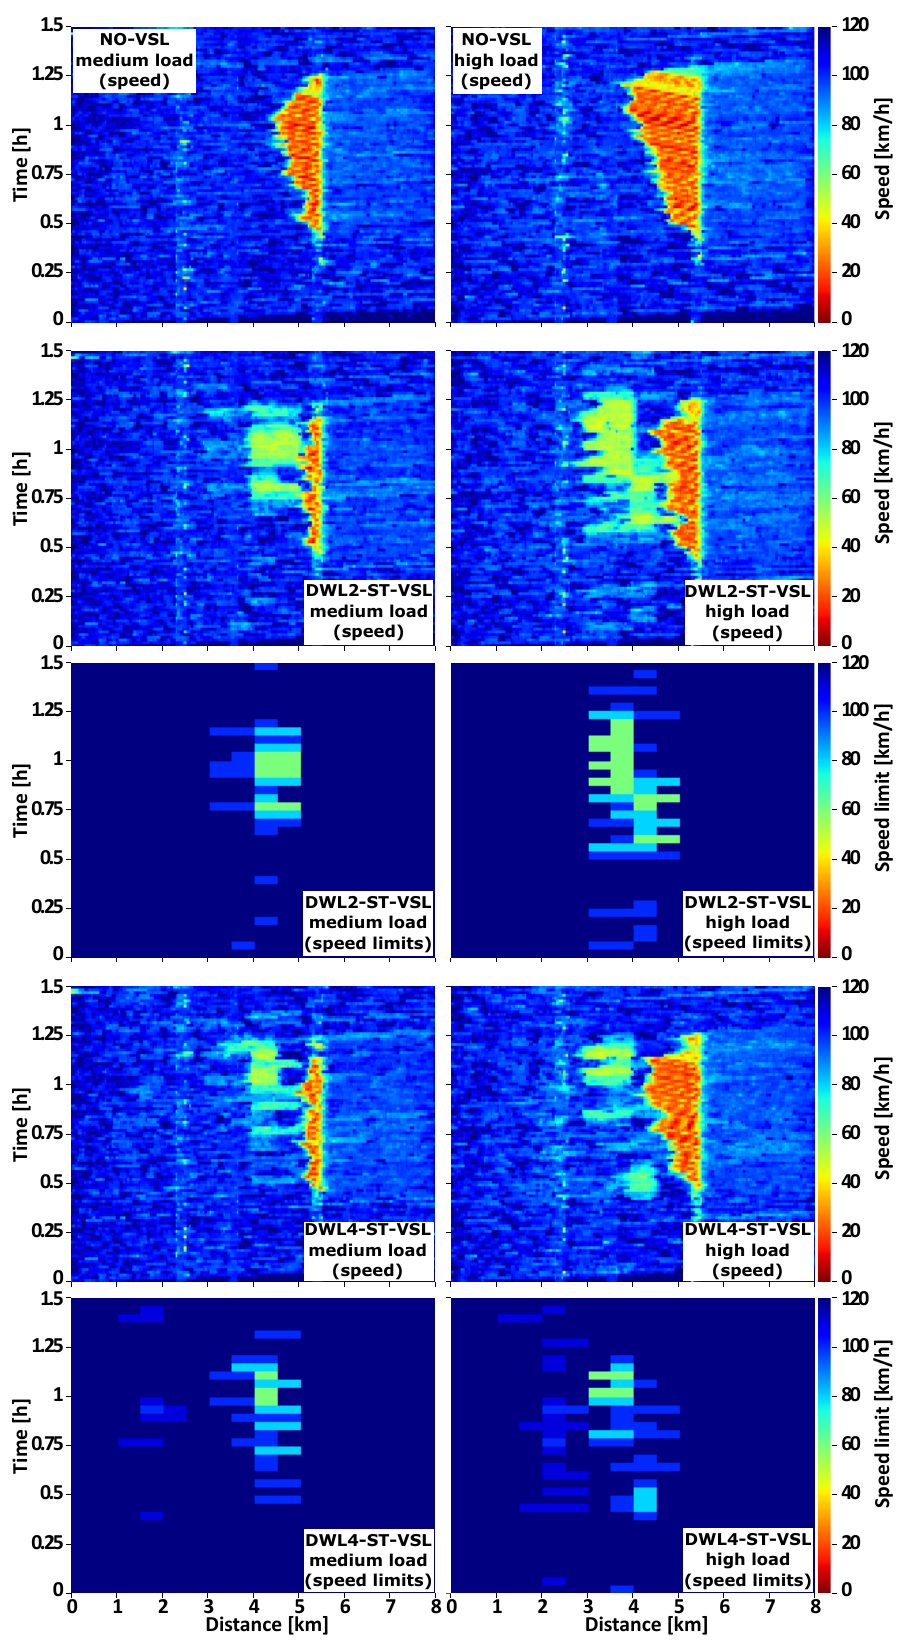
Figure 5. Space-time diagrams for simulated scenarios with multi-agent dynamic VSL